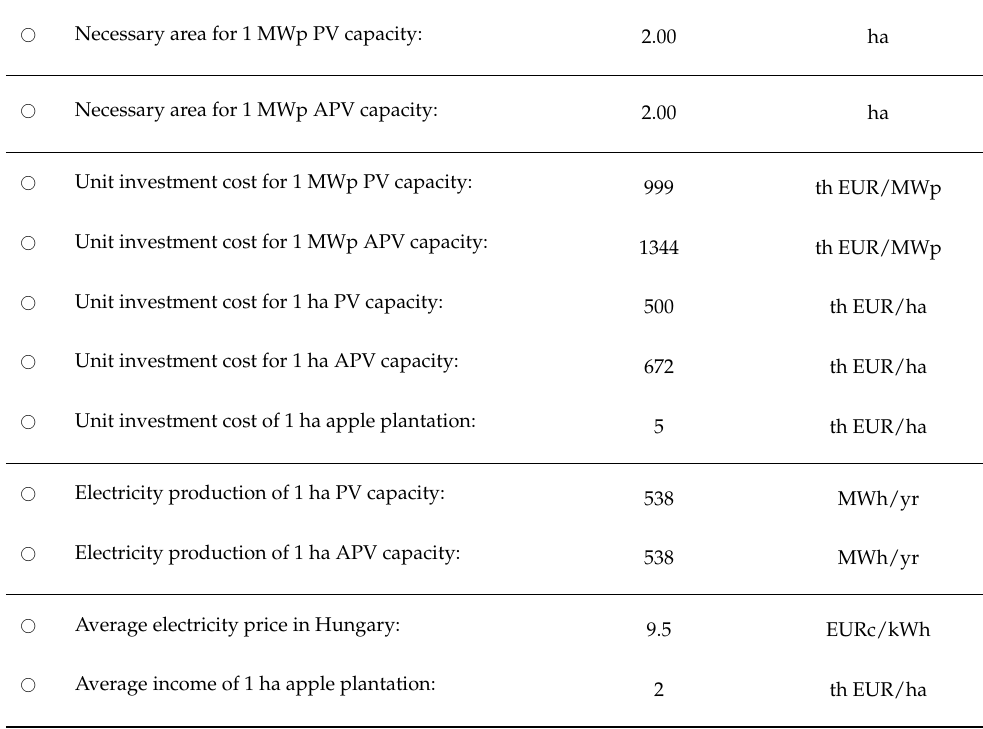
Table 8. Calculation of PV and APV